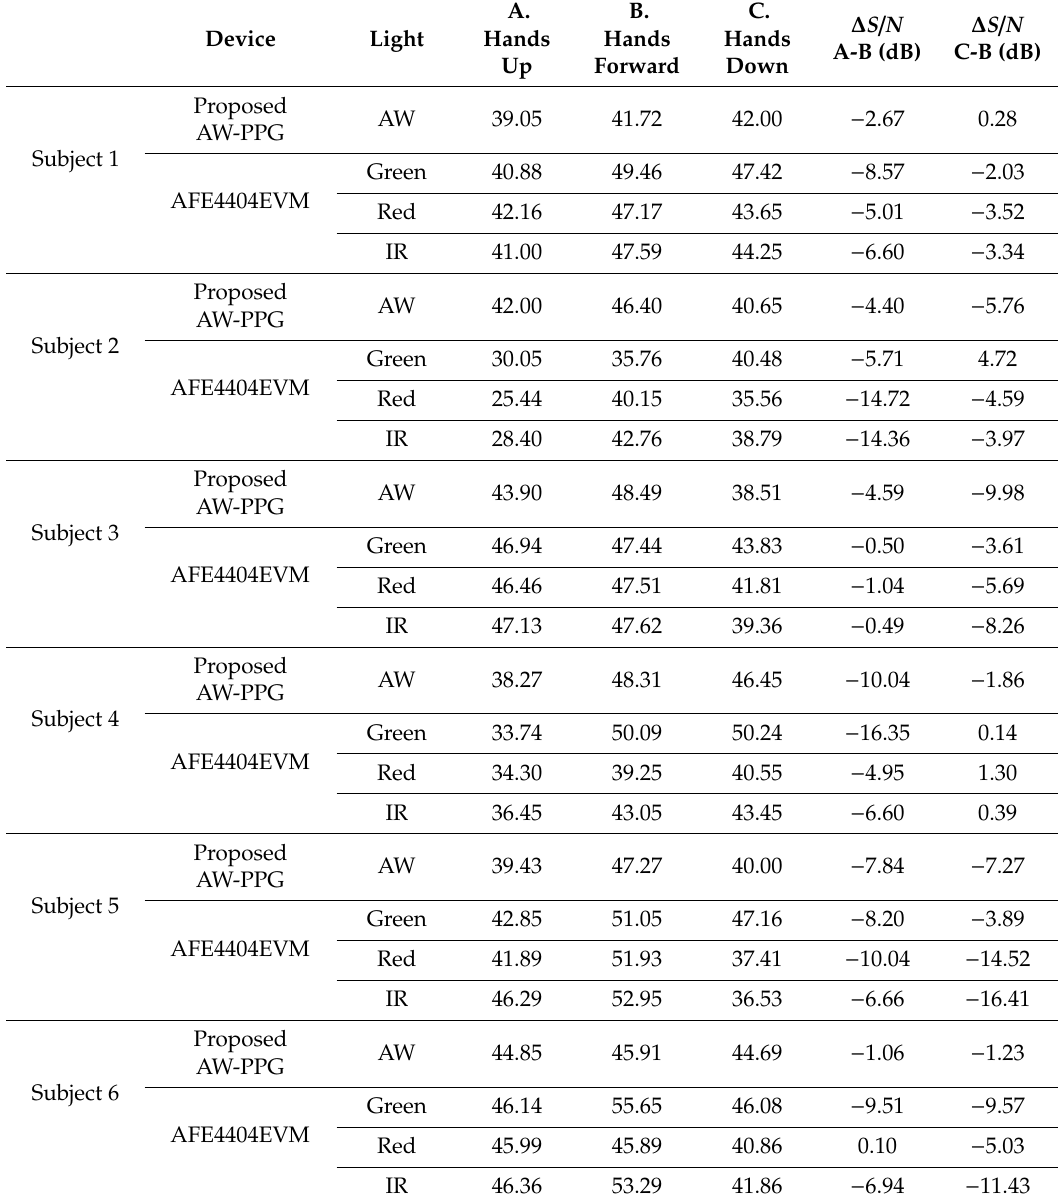
Table 1. ( S / N ) PPG of six subjects in the three measurement